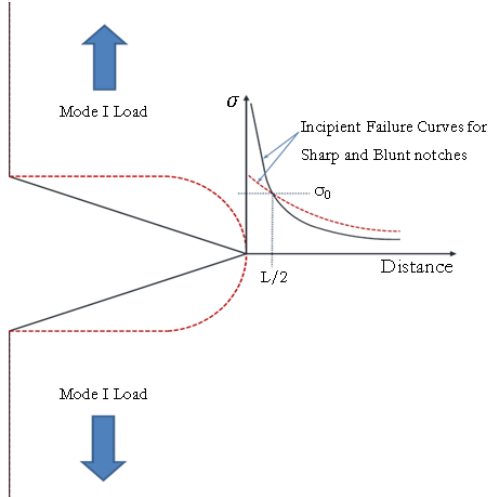
Figure 1: Critical local Stress-Distance curves ahead of two geometrically different stress